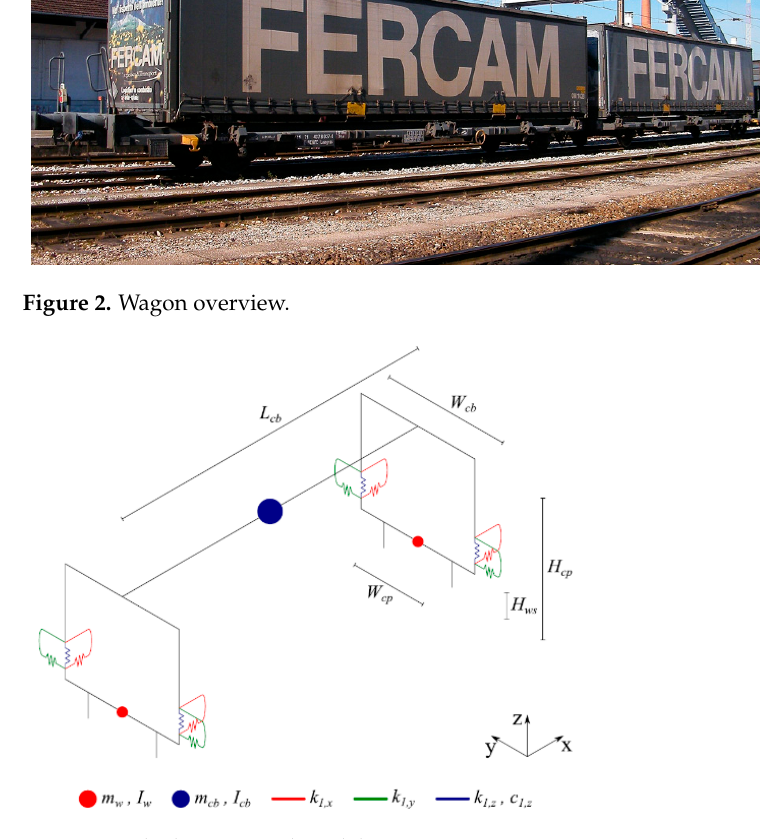
Figure 3. Vehicle numerical model. Table 1. Vehicle mechanical and geometric properties.